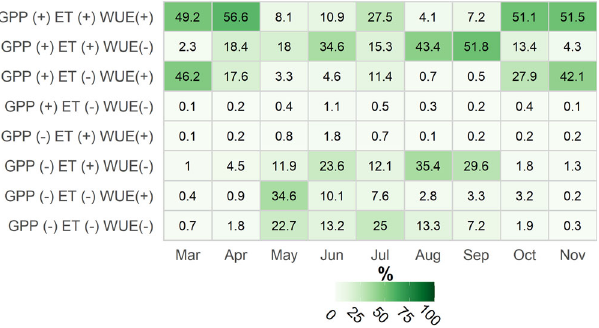
Fig. 5 Proportion of forest core areas based on the interaction among gross primary production, evapotranspiration, and water-use-ef fi ciency. Proportions (%) of the total forest core areas (FCA) that showed an increase ( + ) or decrease ( – ) in gross primary production (GPP), evapotranspiration (ET), and water-use ef fi ciency